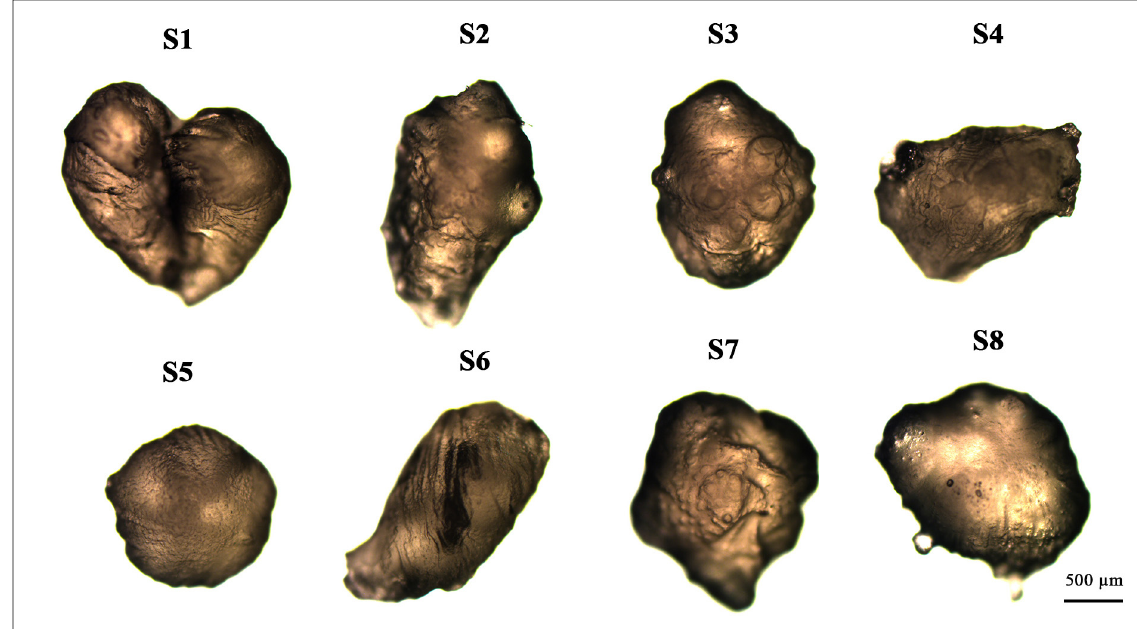
Figure 6. Oregano essential oil-loaded microcapsules’ (dry) surface structural changes. The codes for the microcapsules are given in Table 3. The scale bar for each microcapsule is 500 µm.